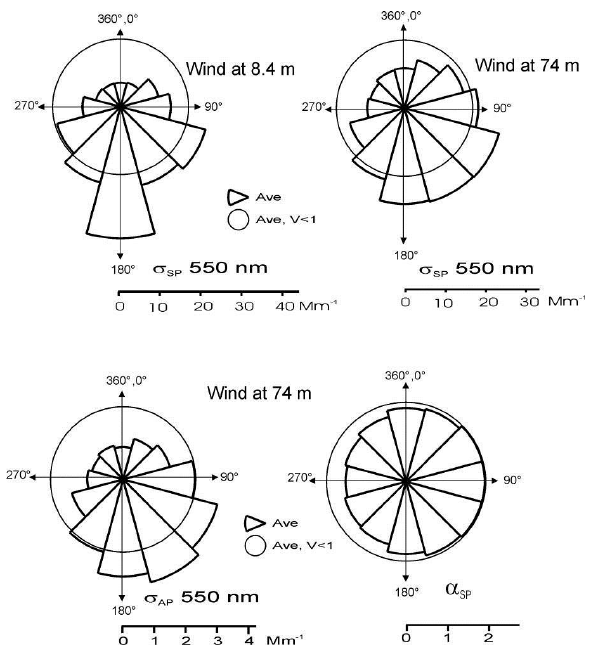
Fig. 16. Average scattering and absorption coefficients at λ = 550nm and ˚Angstr¨om exponent of scattering in 12 wind direction sectors during the whole analysis period. For σ SP the classifica- tion was done both by using wind data measured at the lowest (8.4ma.g.l.) and highest altitudes (74ma.g.l.) in the SMEAR II meteorological